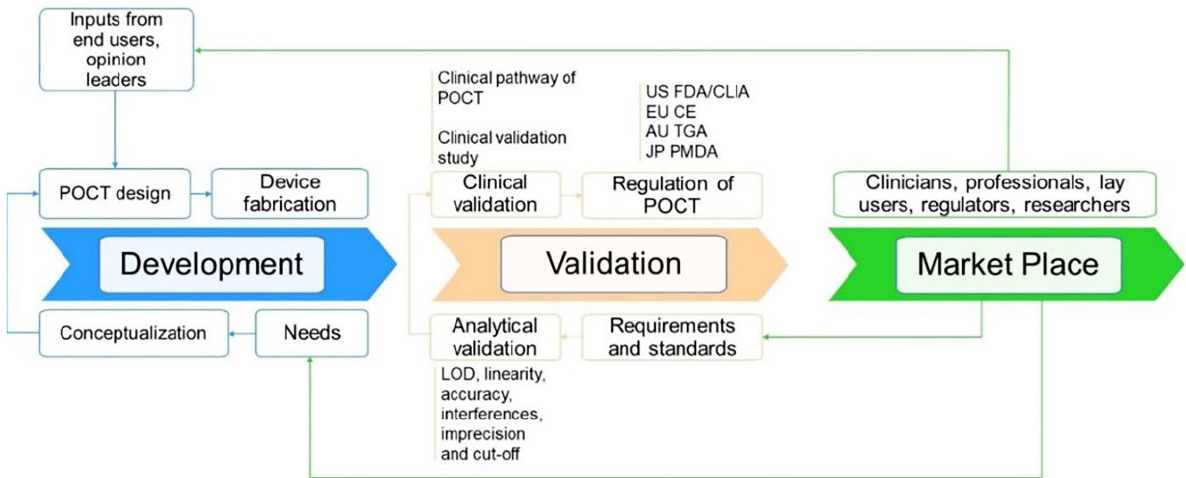
Figure 8. Development, validation, and regulatory pathway of a biosensor PoCT technology and their interconnection. Abbreviation: US FDA—United States Food and Drug Administration, EU CE—European Conformite Europeenne, AU TGA—Australia Therapeutic Goods Administration, JP PMDA—Japan Pharmaceuticals and Medical Devices